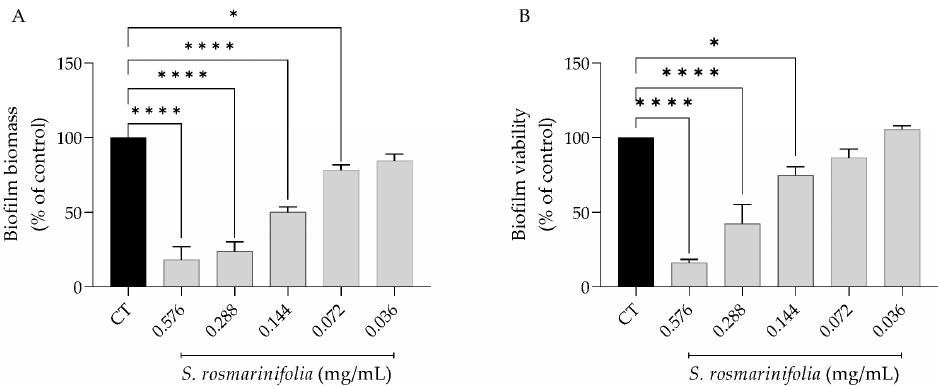
Figure 2. Santolina rosmarinifolia essential oil inhibited biofilm formation 24 h post-seeding. ( A ) Biofilm mass as measured by crystal violet assay. ( B ) Biofilm viability as assessed by XTT metabolization assay. Results show the mean ± SEM of five independent assays made in duplicate. * p < 0.05 and **** p < 0.0001 when compared to control (CT).